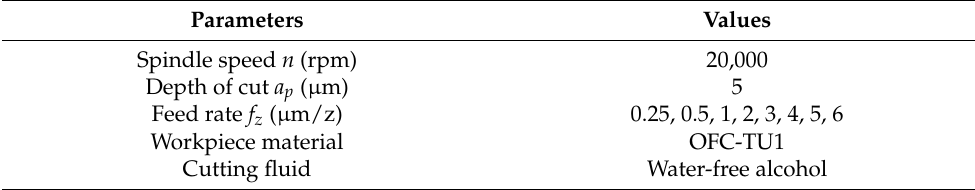
Table 4. Details of the parameter experiments.